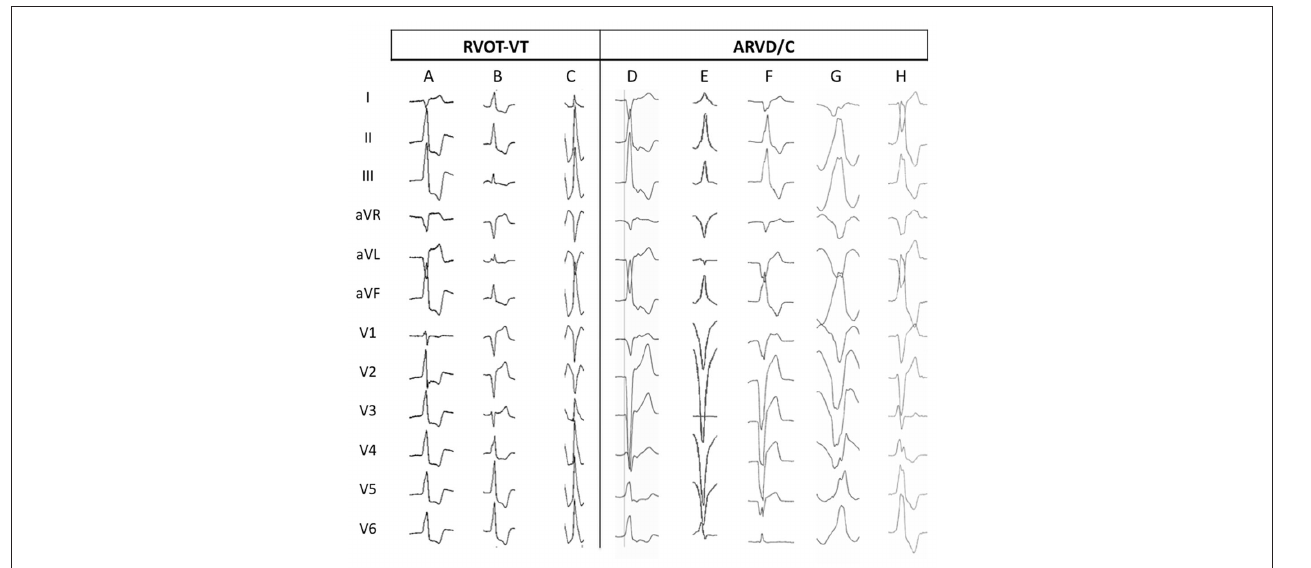
Figure 2 | Ventricular tachycardia morphology characteristics (Hoffmayer et al., 2011) . Twelve lead ECGs from patients with RVOT-VT (A–C) and ARVD/C (D–H) showing characteristic features. (A) RVOT-VT from anterior–septal location, showing precordial transition at V2, and narrow QRS duration in lead I (78 ms). (B) RVOT-VT originating superior to his bundle region, showing precordial transition at V4, positive R wave in aVL and narrow QRS in lead I (86 ms). (C) RVOT-VT from posterior–septal location, showing precordial transition at V3, and narrow QRS duration in lead I (118 ms). (D) ARVD/C VT